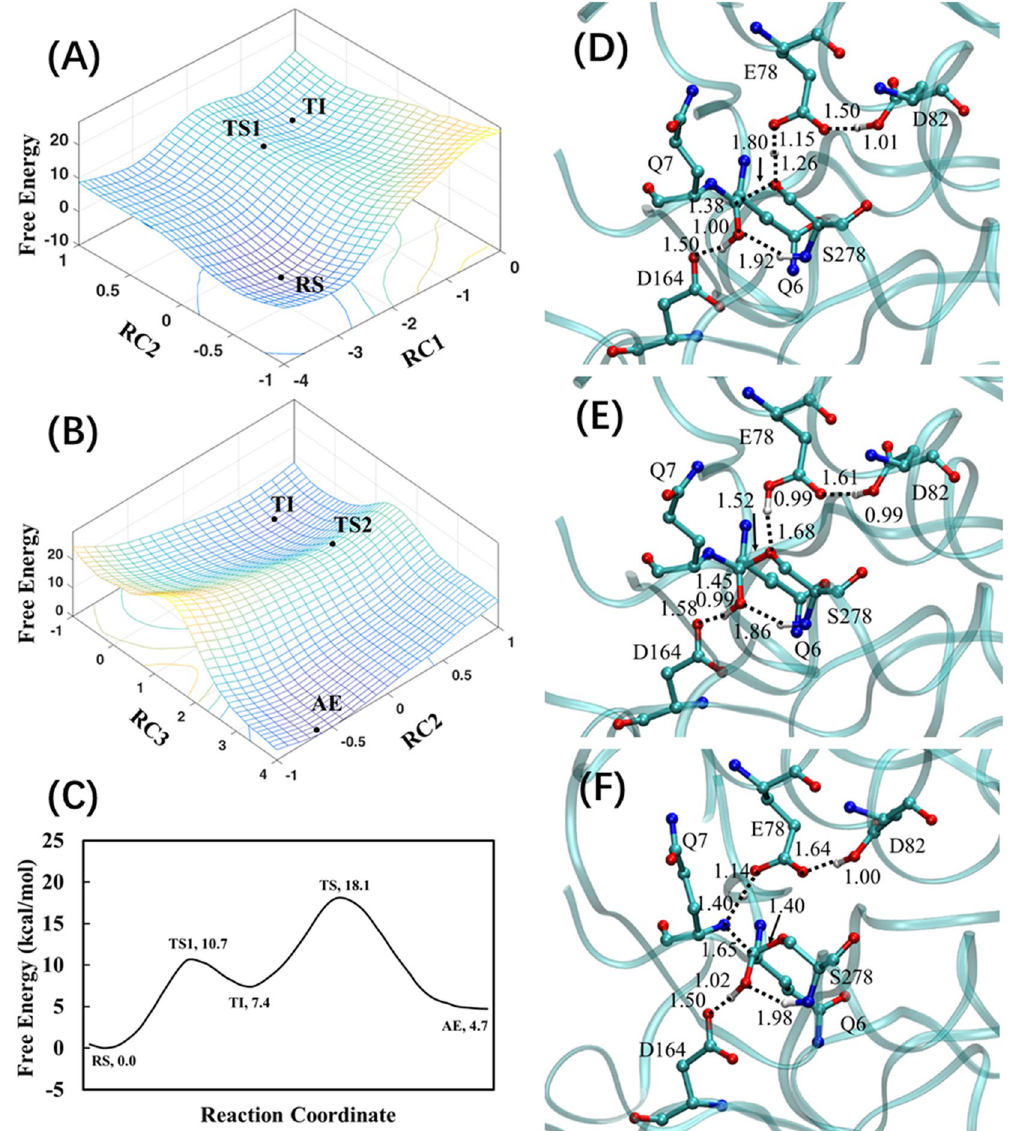
Figure 4. Free energy maps and average structures of Kuma030 with the substrate peptide (PFPQPQQPF) for acylation process. ( A ) Use of RC1 and RC2 to simulate the formation of the TI in the acylation process; ( B ) RC2 and RC3 to simulate the decomposition of the TI. ( C ) Minimum free energy profile plotted on the basis of Fig. 4A,B. Average structures of TS1 ( D ), TI ( E ), and AE ( F ). The distances are all in Å. The energies are in kcal/mol. All transition states are approximate